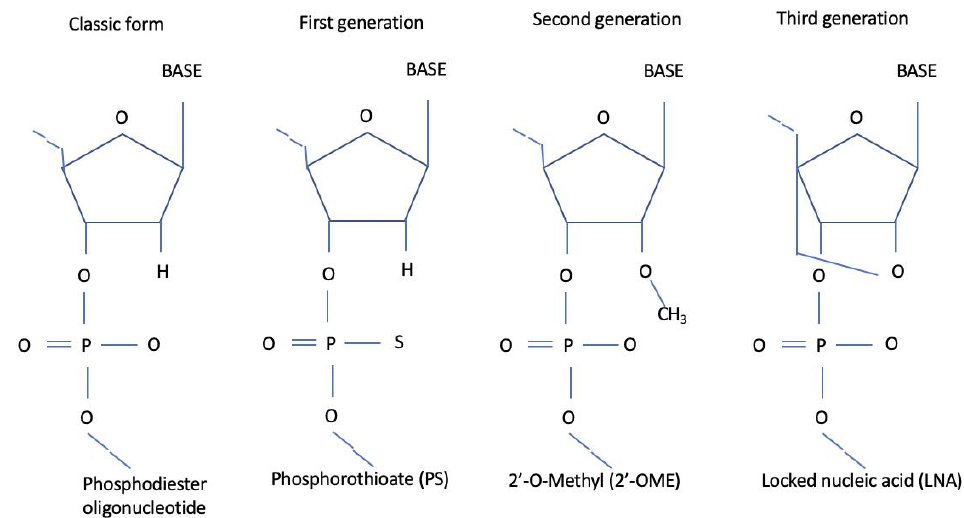
Figure 2. Different ASO generations.